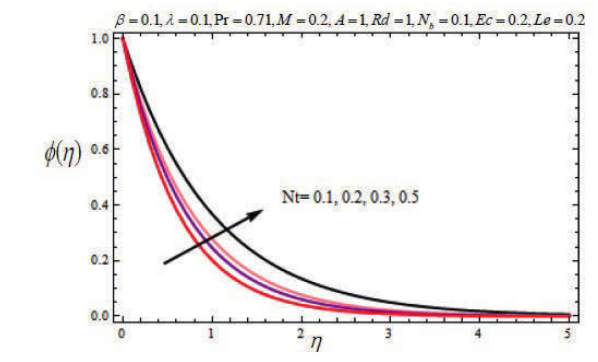
Fig. 18: Variation of nanoparticle concentration with η for several values of thermophoresis parameter N t .